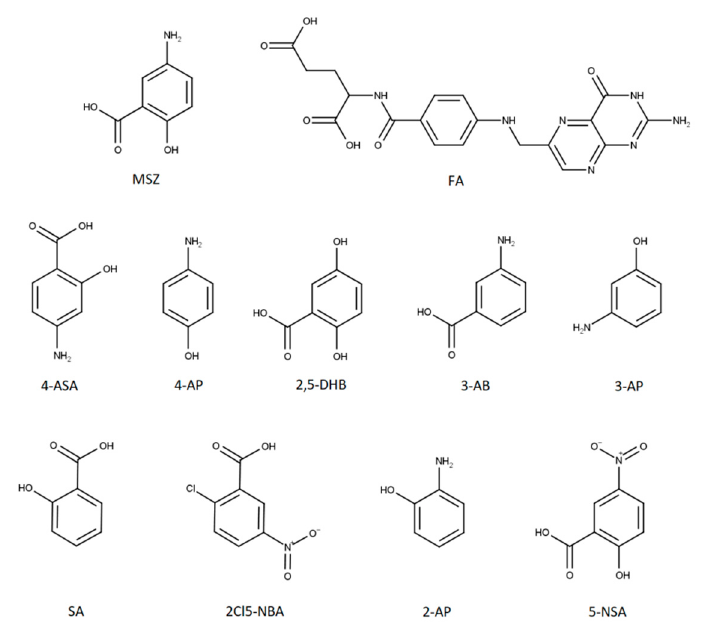
Figure 1. Structures of mesalazine (MSZ), folic acid (FA) and MSZ-related impurities.